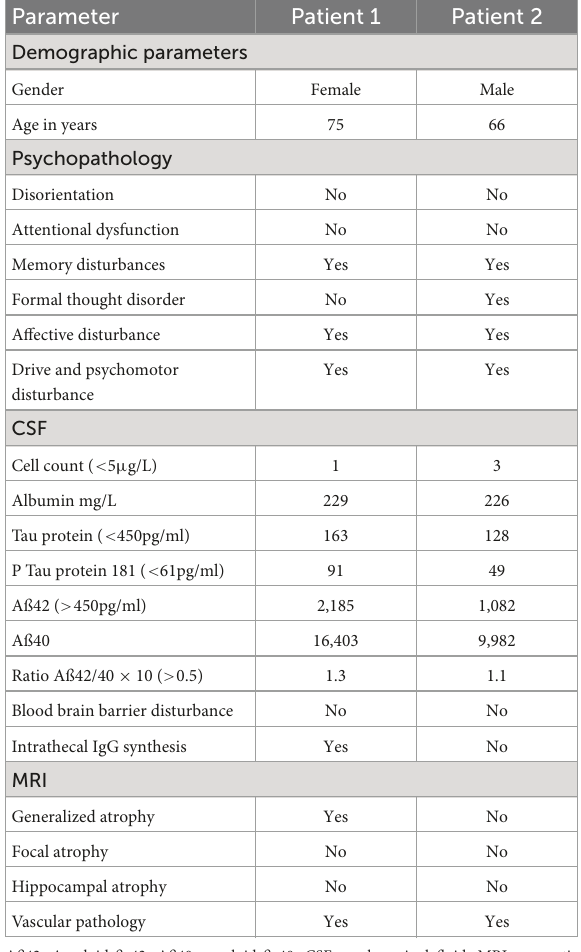
TABLE 2 Clinical and laboratory characteristics of